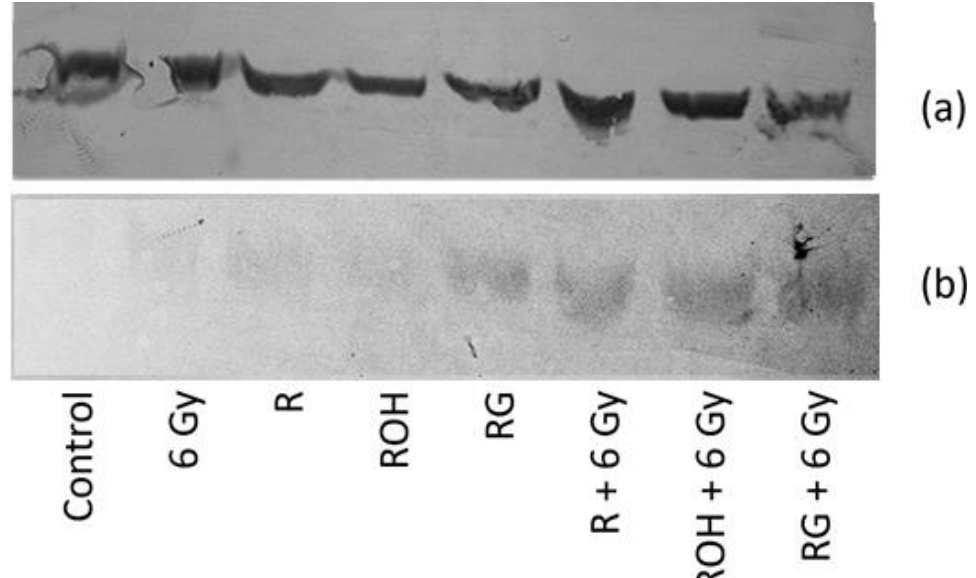
Figure 6. Protein levels of β -actin ( a ) and caspase 8 ( b ) in MCF-7 cells treated with 25 µ M of resveratrol (R), piceatannol (ROH), and piceid (RG) alone and in combination with IR (dose of 6 Gy). MCF-7 cells were incubated with stilbene and/or IR for 24 h. The lysates were resolved by SDS-PAGE and analysed via the Western blot technique; primary mouse antibodies β -actin (1:1000 dilution) and caspase 8 (1:500).